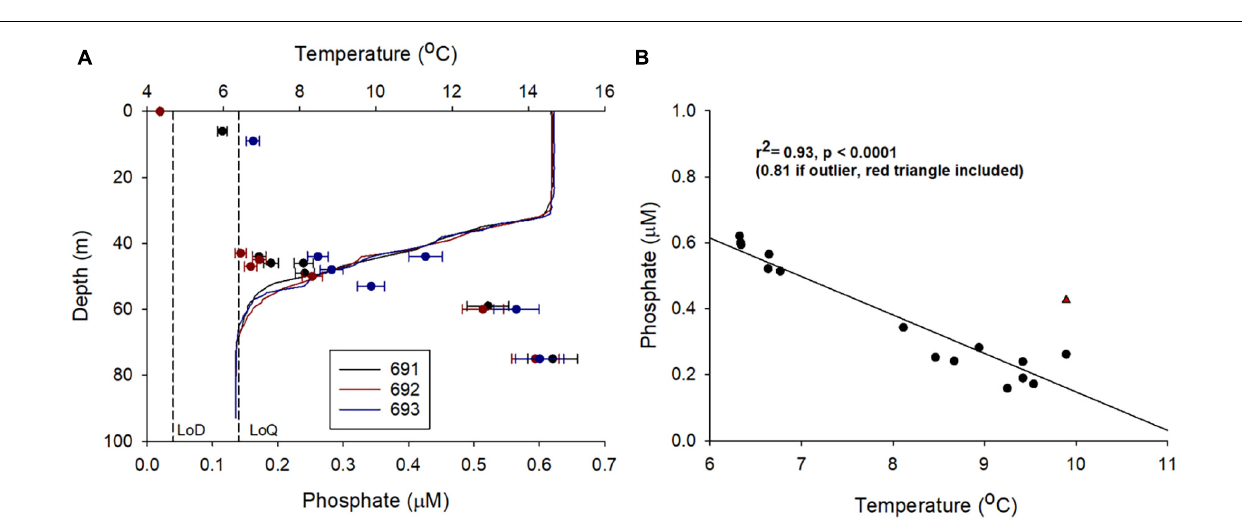
FIGURE 9 | Examining LoC analyser field precision by conducting PO 43 − analysis during three sequential Seaglider dives (691, 692, and 693), first and last sample separated by 1.98 km and 4.00 h. (A) Depth profiles of temperature and PO 43 − concentration. Vertical dashed lines are laboratory estimates of the limit of detection (LoD) and limit of quantification (LoQ) (Clinton-Bailey et al., 2017; Grand et al., 2017). Error bars are laboratory estimates of combined (random + systematic) relative uncertainty (Birchill et al., 2019a). (B) Statistically significant inverse linear correlation between temperature and PO 43 − concentration from dives 691, 692, and 693 for samples collected below 40